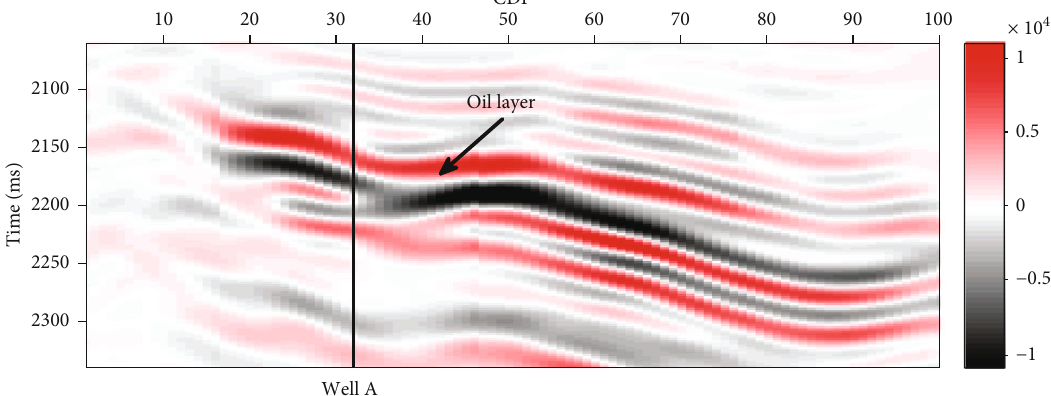
Figure 7: Stacked section from the test area. The black line indicates the location of Well A, and the arrow indicates the target